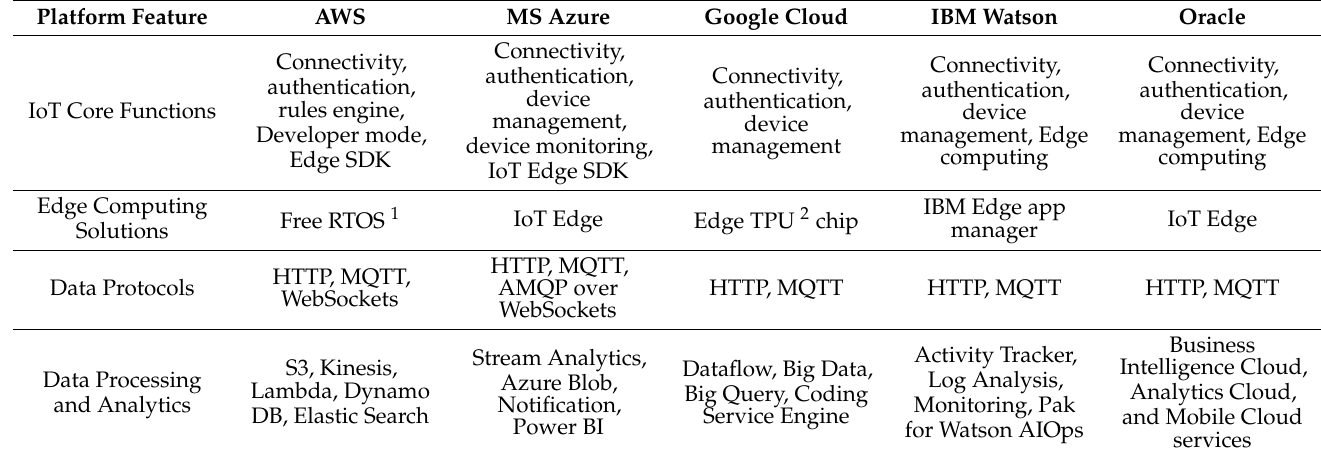
Table 1. A comparison of the most widely used IoT